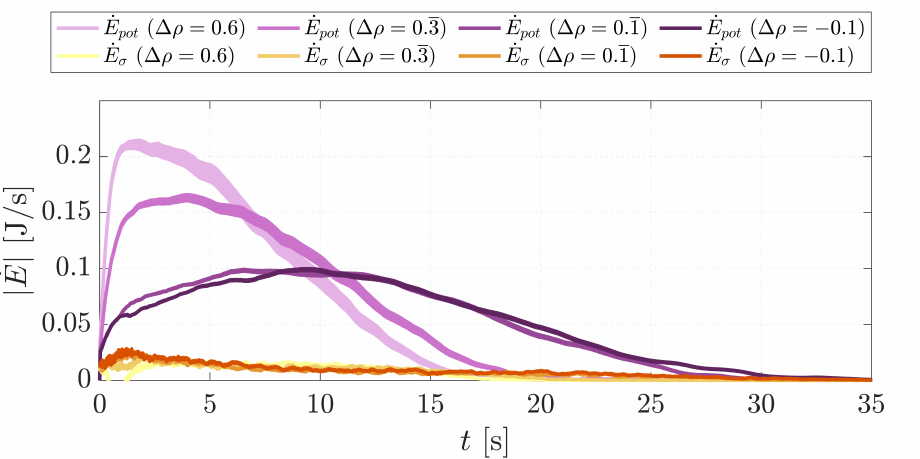
Figure 8. Magnitudes of the energy release rates due to the reduction in the net potential height ˙ E pot , and the reduction in the interface area ˙ E σ